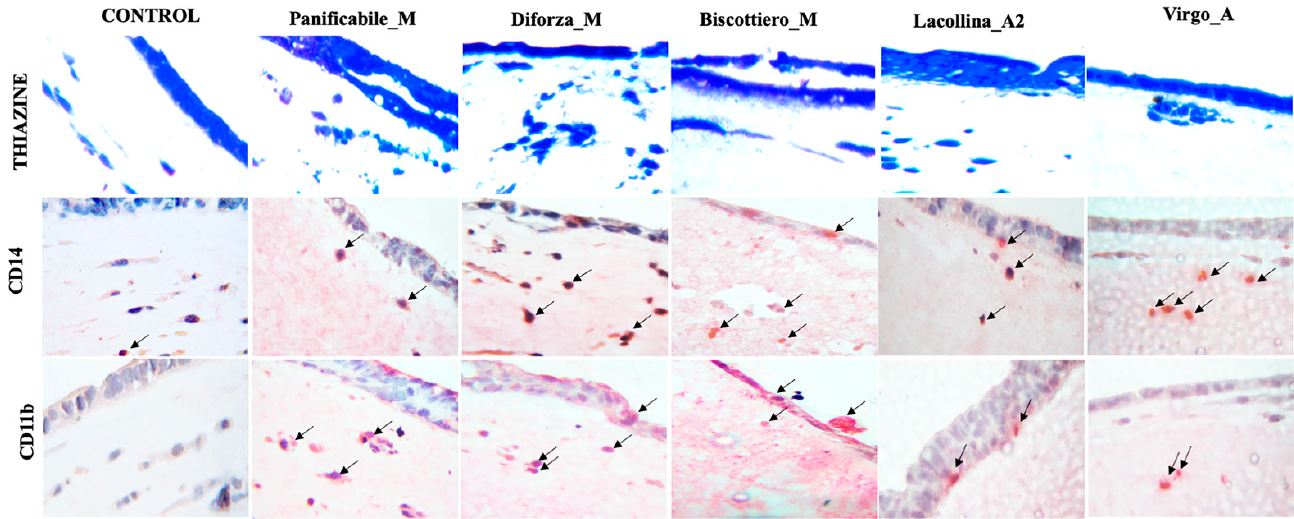
Figure 8. Thiazine staining as well as CD14 staining of U937 monocytes and CD11B U937 differentiated macrophages in 3D intestinal equivalents (Caco-2/U937/L929 co-cultures) exposed to no added protein (control) or 40 µg/mL total protein from three commercially available modern wheat mixes (denoted by M) and two heritage wheat mixes (denoted by A) for a period of 24 h. For CD14 and CD11b staining, fast red was used as a chromogen and nuclei were counterstained with eosin. Arrows indicate the presence of monocytes (CD14 positive cells) and macrophages (CD11b positive cells). The magnification was ×40.